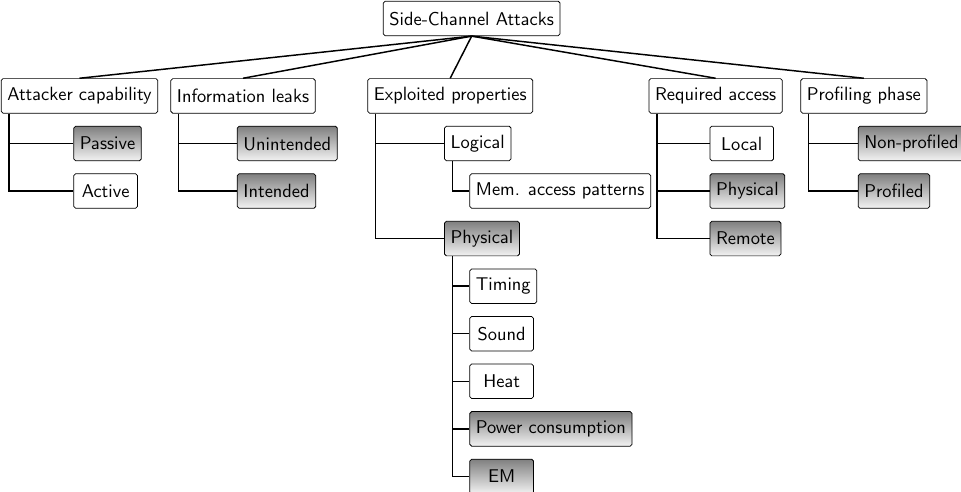
Figure 2. A general taxonomy of SCA attacks. Gray boxes highlight the features covered by the attacks surveyed in this